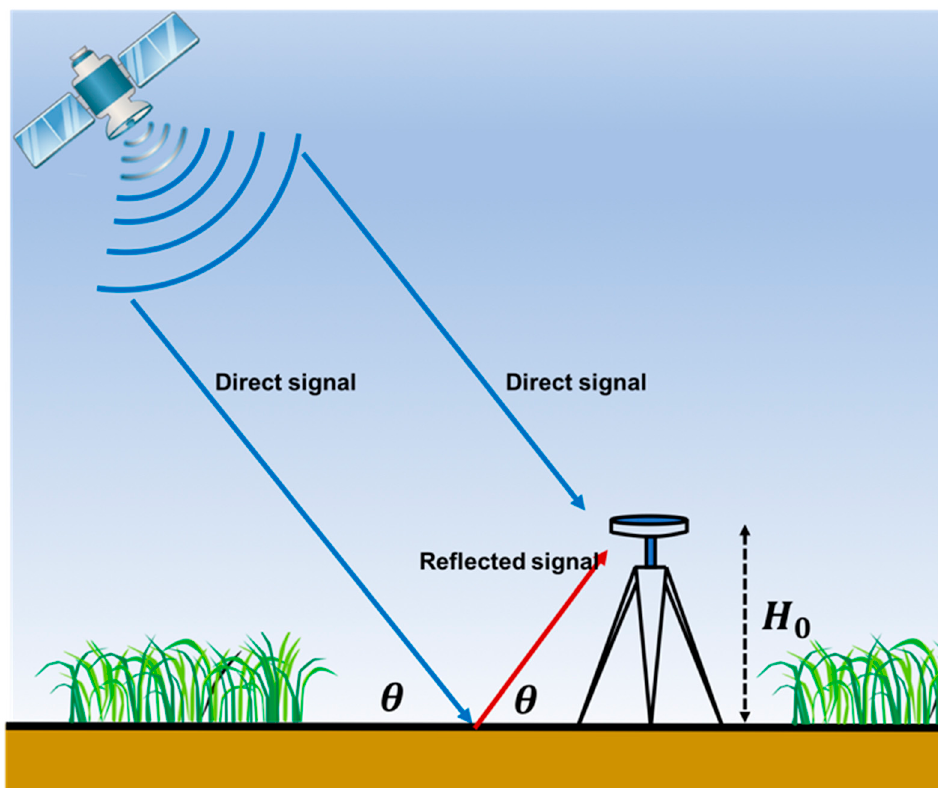
Figure 1. Geometrical relationship of a reflected signal and direct signal for satellite elevation angle ( θ ) and antenna height ( H 0 ). Blue lines represent the direct signal transmitted from the satellite, the red line is the reflected signal from the ground. The received signals are the combination of direct signals and reflected signals.